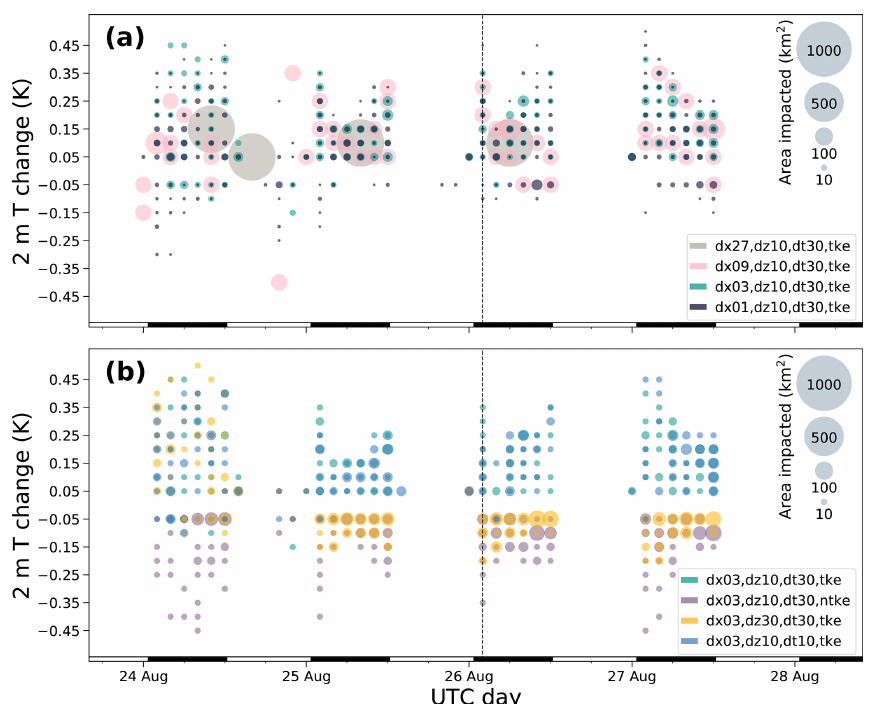
Figure 12. Time series of area impacted by the wake-induced, 2m temperature changes as predicted by the tested simulations, plotted every 2h throughout the period. The size of the dots represents the spatial coverage of their respective magnitude of impact (scale denoted in top right), with each dot colored based on its configuration. The configurations are divided into groups that (a) vary horizontal resolution and (b) hold horizontal resolution constant while varying other model settings. The time chosen for the qualitative analysis (26 August 02:00UTC) in Fig. 6 is denoted by the black dashed line. Black and white bar at bottom denotes post-sunrise (white) and post-sunset (black) times.